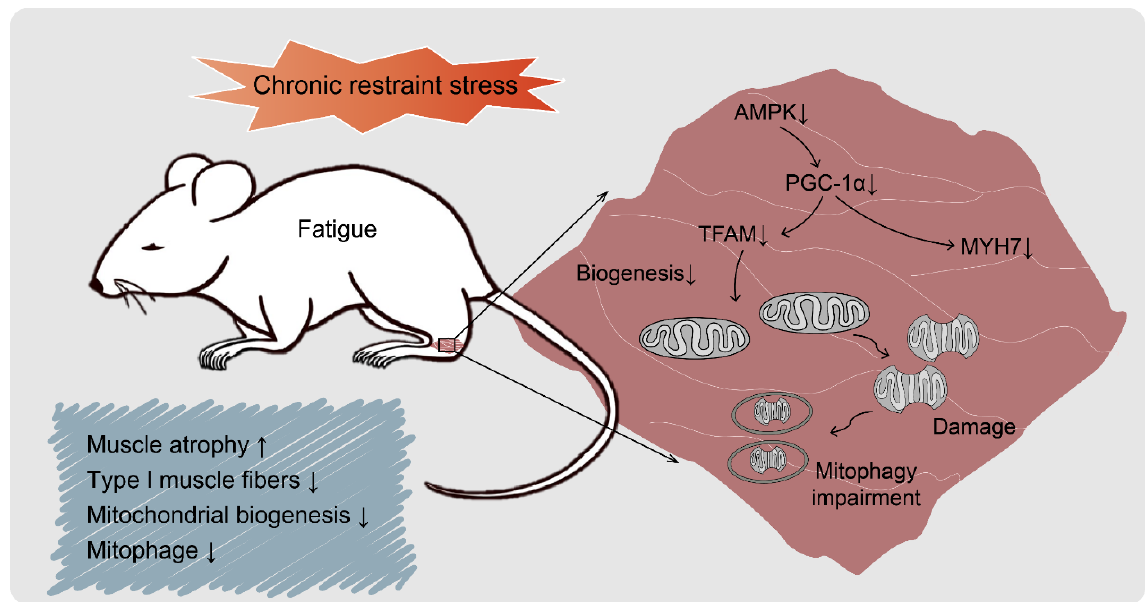
Figure 8. Schematic diagram of the molecular target pathways involved in CRS-induced fatigue. CRS suppressed AMPK phosphorylation and then inhibited AMPK/PGC-1α signaling pathway cascade, thereby subsequently inducing muscle atrophy, decreasing type I muscle fibers, decreasing mitochondrial biogenesis, and suppressing protective mitophagy of the gastrocnemius.